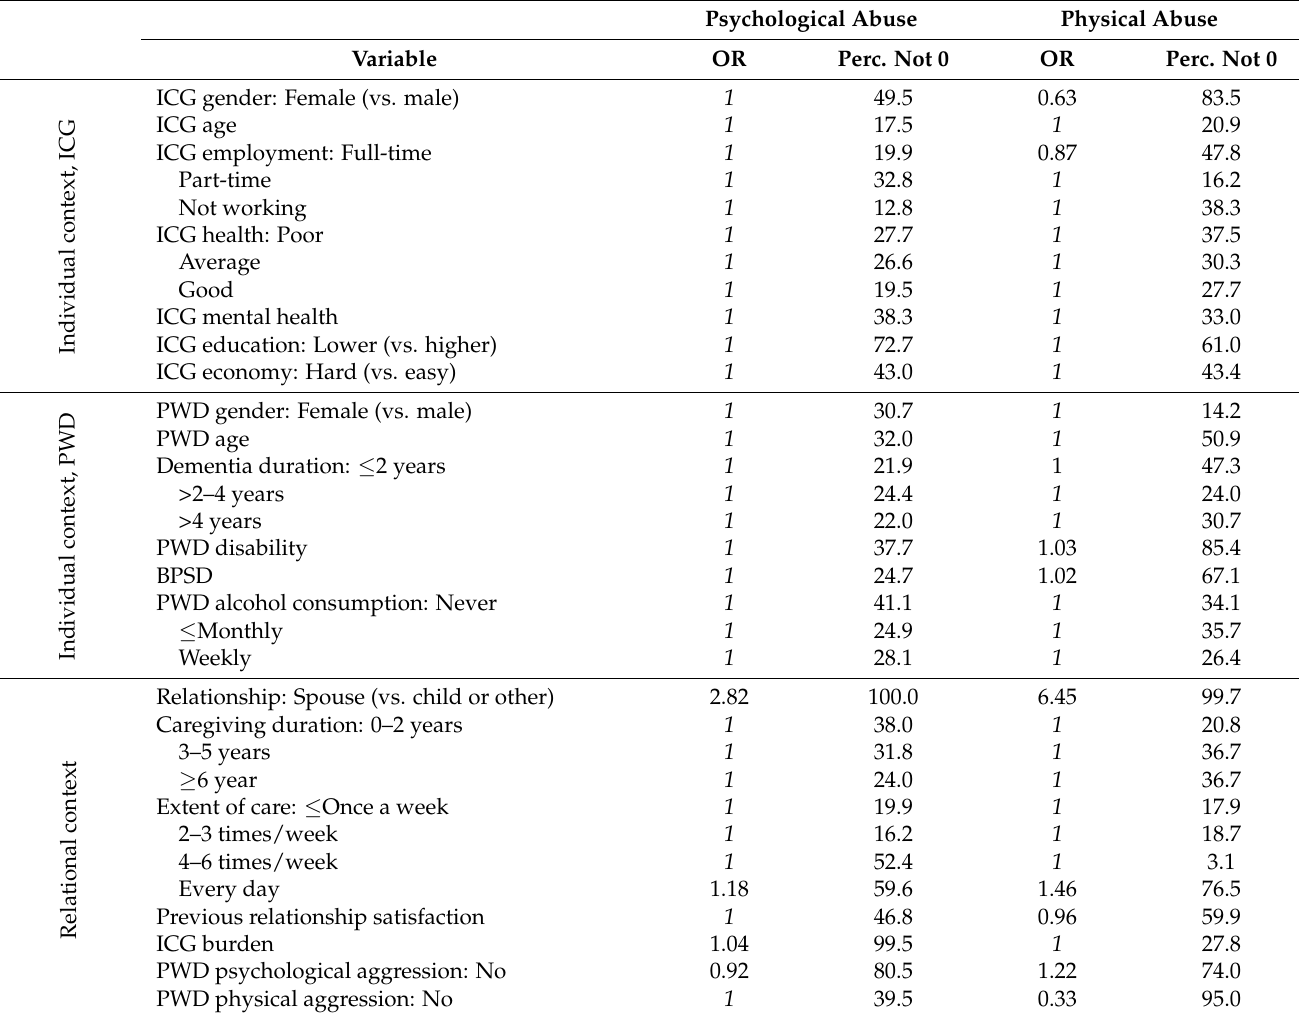
Table 3. Penalized odds ratios (OR) from lasso and percent not null from 1000 bootstrap samples ( n =